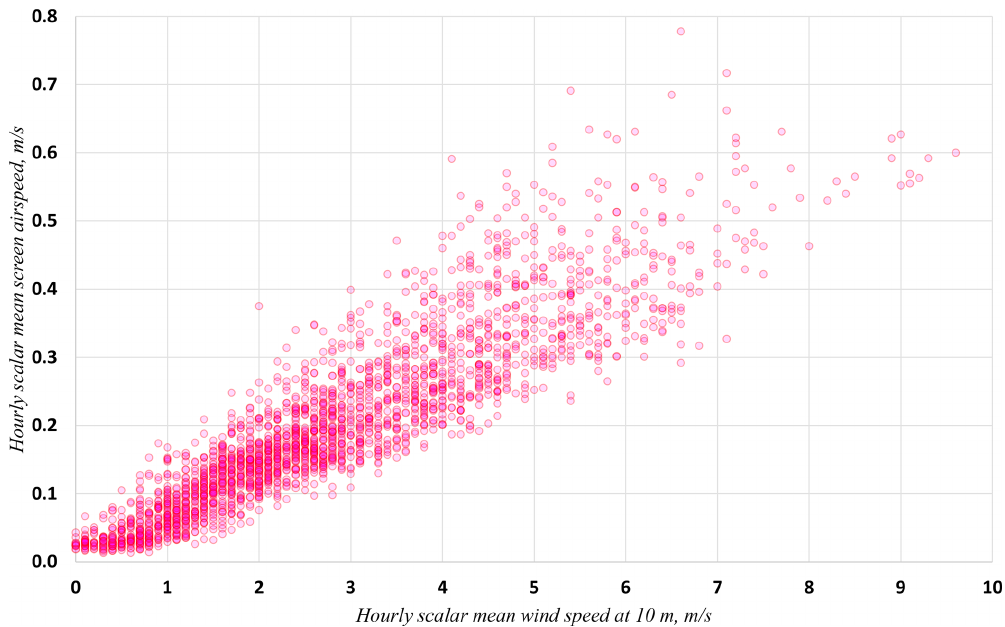
Figure 3. Hourly scalar mean wind speeds within the screen ( U screen ) plotted against the external 10m scalar mean wind speed U 10 for the period 13 February to 27 May 2020. Units ms − 1 .